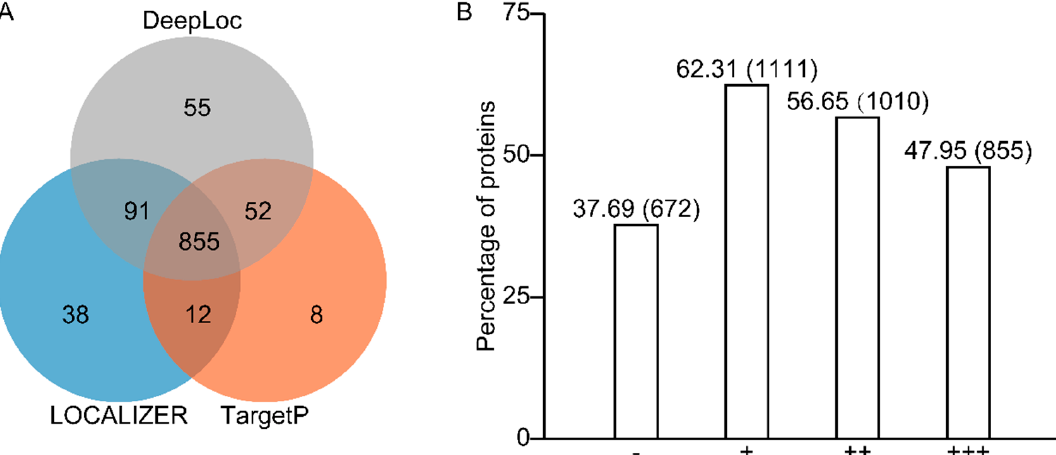
Figure 1. Chloroplast localization prediction for the identified 1783 nuclear-encoded proteins by TargetP, LOCALIZER, and DeepLoc. ( A ) The Venn diagram shows numbers of chloroplastic positives predicted by three different tools. ( B ) “+” “++” “+++” indicates prediction to be chloroplast by one to three programs, and “ − ” indicates prediction by none. Combination details of the predictions are given in Supplemental Table S2.